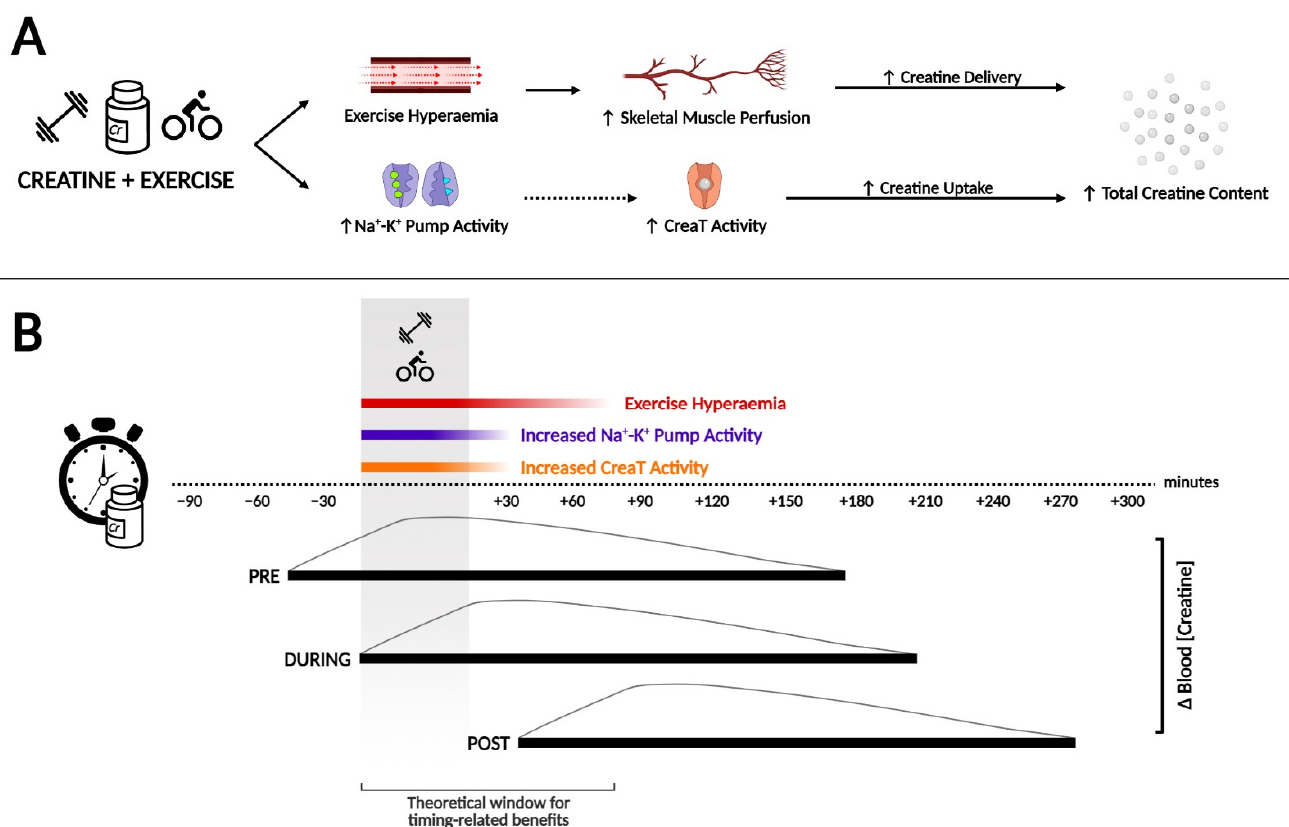
Figure 1. The hypothetical mechanisms behind an exercise-mediated increase in total creatine content with creatine supplementation. ( Panel A ): exercise hyperaemia increases tissue perfusion, enhancing creatine delivery. Additionally, increased Na+/K+ pump activity during exercise supports the [Na + ] gradient favouring creatine uptake by CreaT. Together, these effects may acutely potentiate the uptake and increase in total muscle creatine content. ( Panel B ): theoretical overlap of events according to the timing of creatine supplementation, in relation to exercise and its potential benefits regarding the delivery and uptake of creatine to the muscle. Created with BioRender.com.